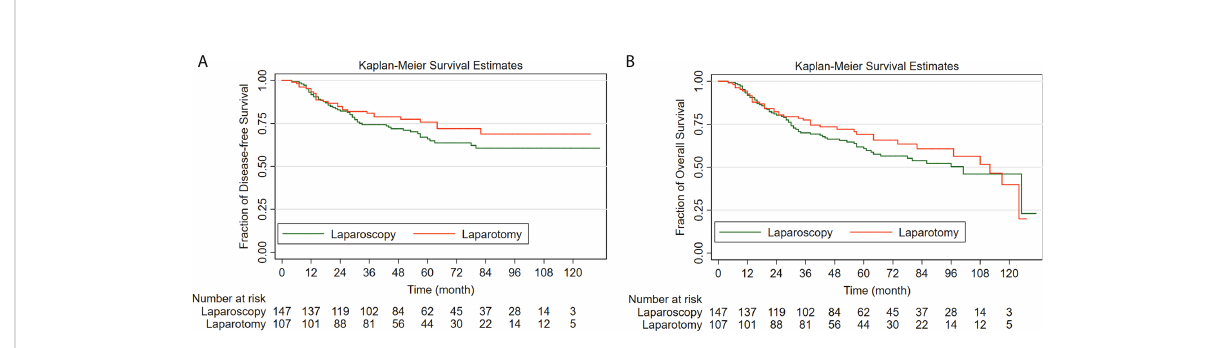
FIGURE 2 The Kaplan-Meier survival curves of the study cohort by laparoscopy versus laparotomy (A) for disease-free survival; (B) for overall